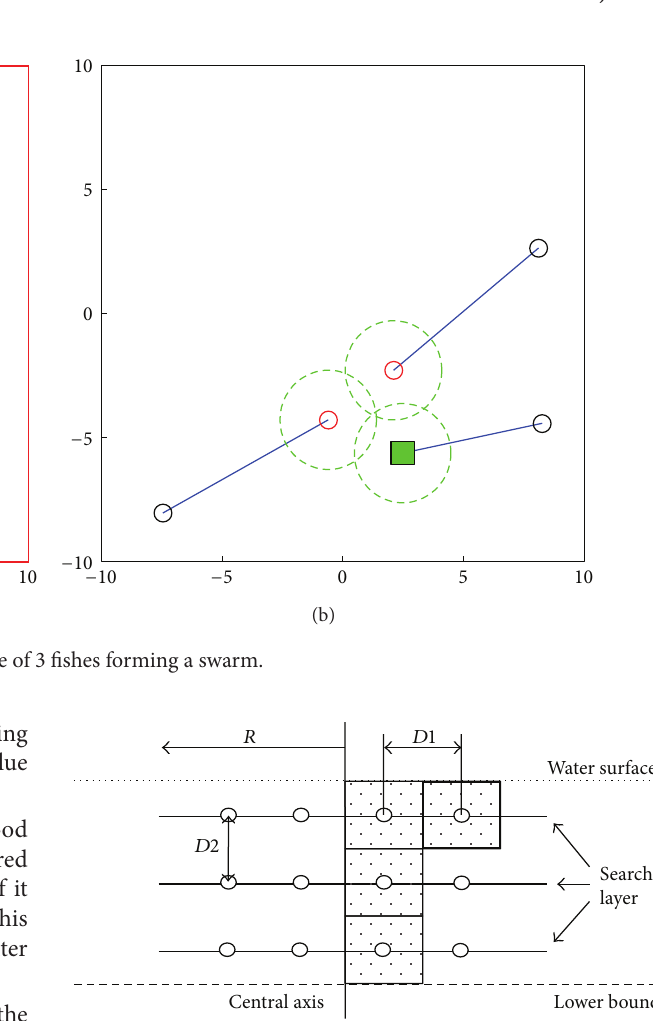
Figure 7: Diagrammatic sketch of search